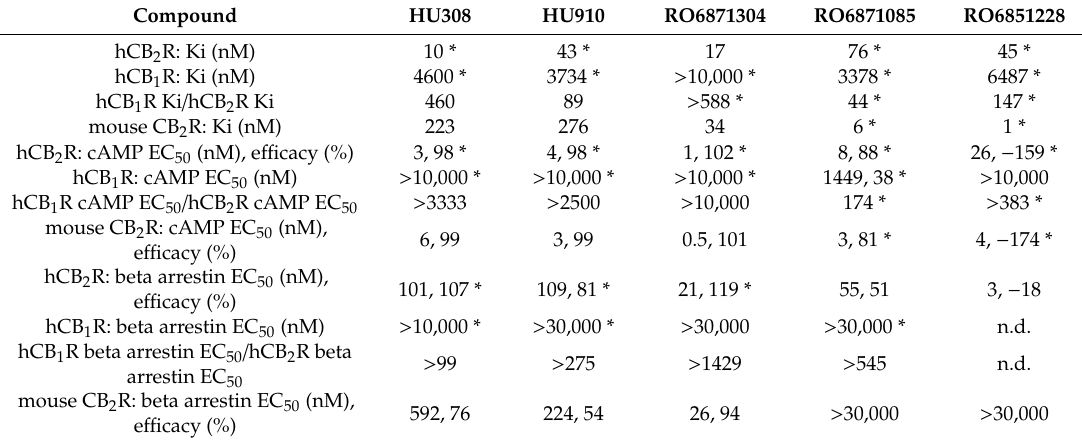
Table 2. In vitro pharmacology data for cannabinoid 2 receptor (CB 2 R) agonists HU308, HU910, RO6871304, RO6871085, and CB 2 R inverse agonist RO6851228. (These data have been generated at